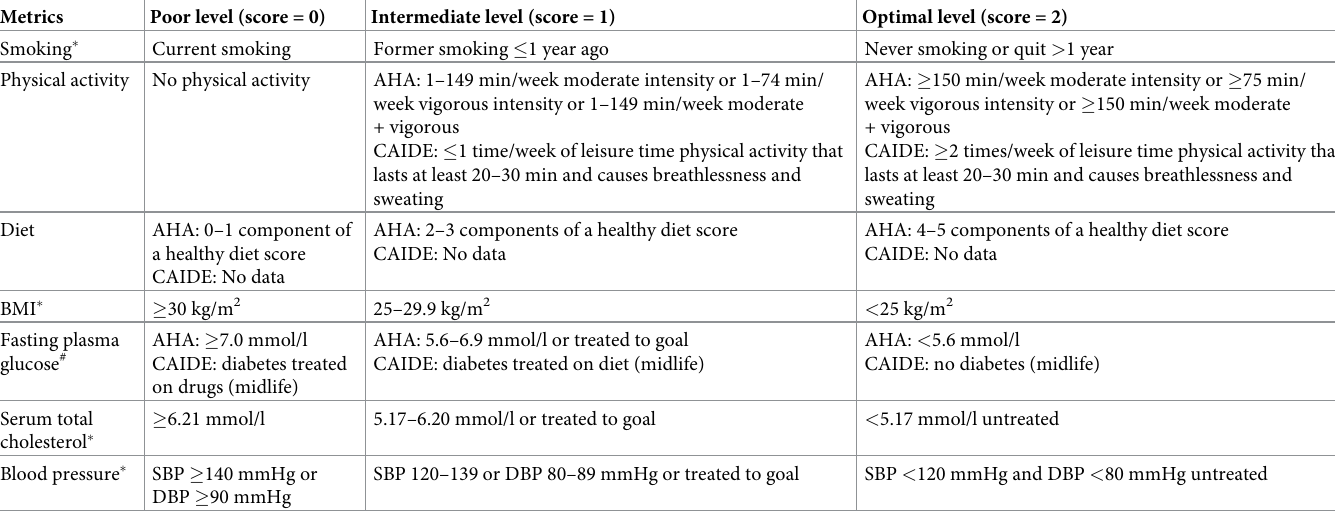
Table 1. Definitions of CVH metrics in the recommendations of AHA and in the study of